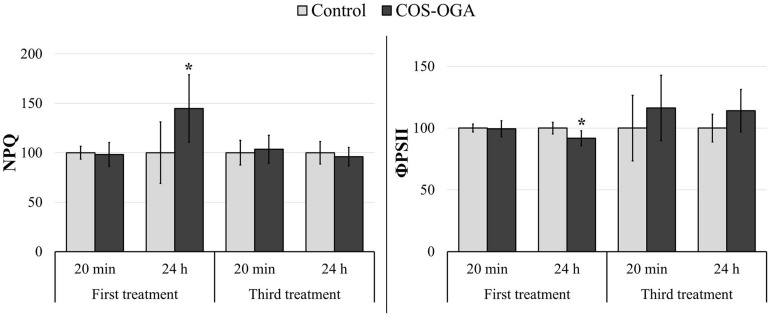
Chlorophyll fluorescence parameters of tomato plants 20 min and 24 h after the first and the third sprayings with chitooligosaccharides–oligogalacturonides (COS-OGA; 62.5 mg/l). PSII operating efficiency (ΦPSII) and non-photochemical quenching (NPQ) were calculated from fluorescence kinetic data generated during the quenching protocol (Fluorcam). These parameters were determined after 20 min dark adaptation. The average values of fluorescence parameters are expressed as a percentage of the control ± standard deviation (n = 6). *indicates a statistically significant difference to control with p < 0.05 (Student’s t test, R).